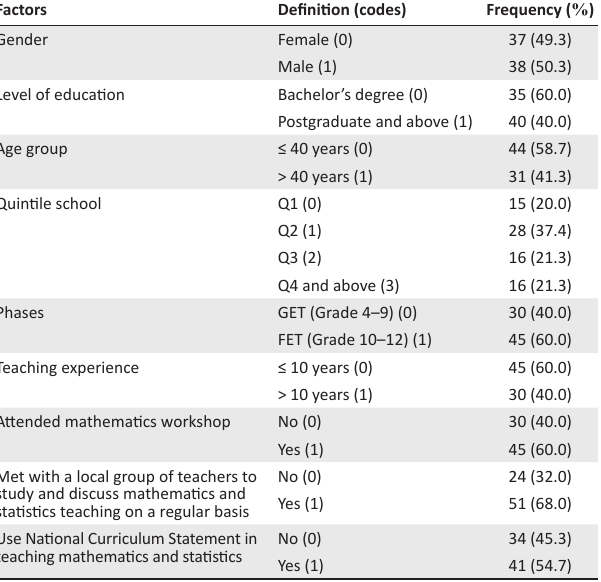
TABLE 1: Participants by demographic factors.